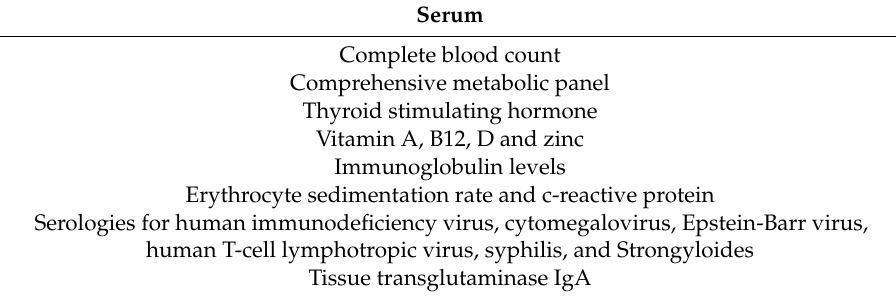
Table 1. Laboratory studies ordered at initial